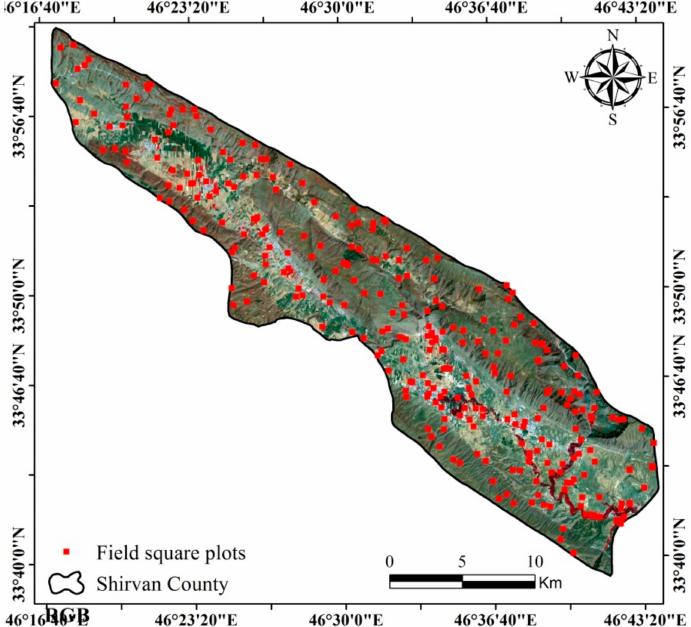
Figure 4. Location of 300 field square plots and Sentinel-2 satellite image of Shirvan